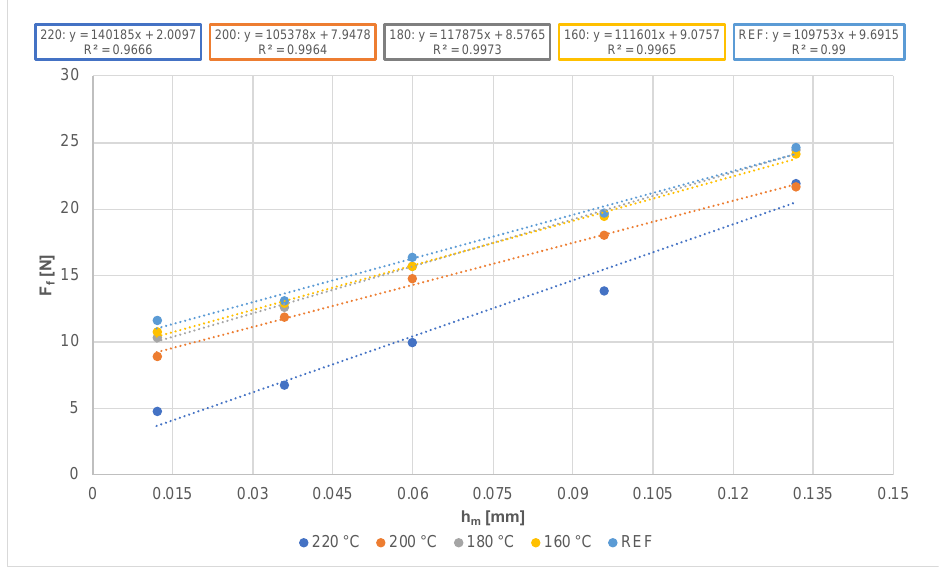
Figure 6. Dependance of average values of feed force on uncut chip thickness.